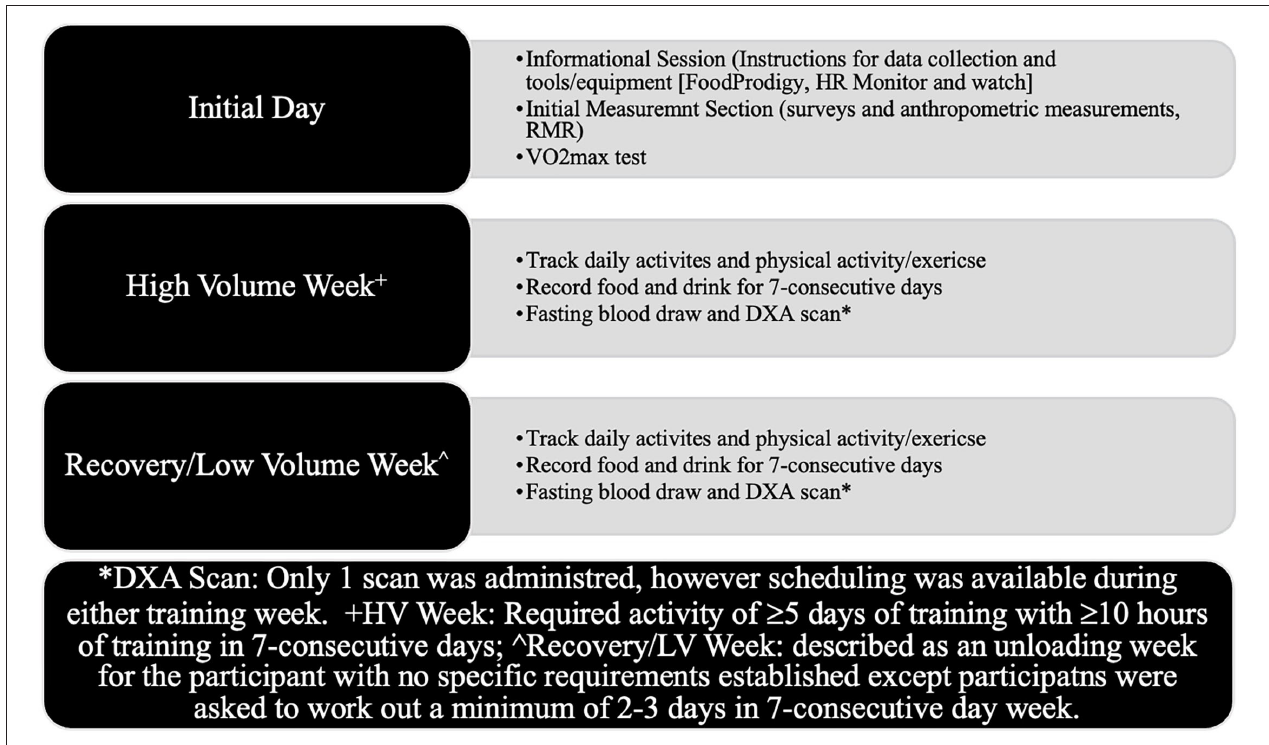
FIGURE 1 | Data collection